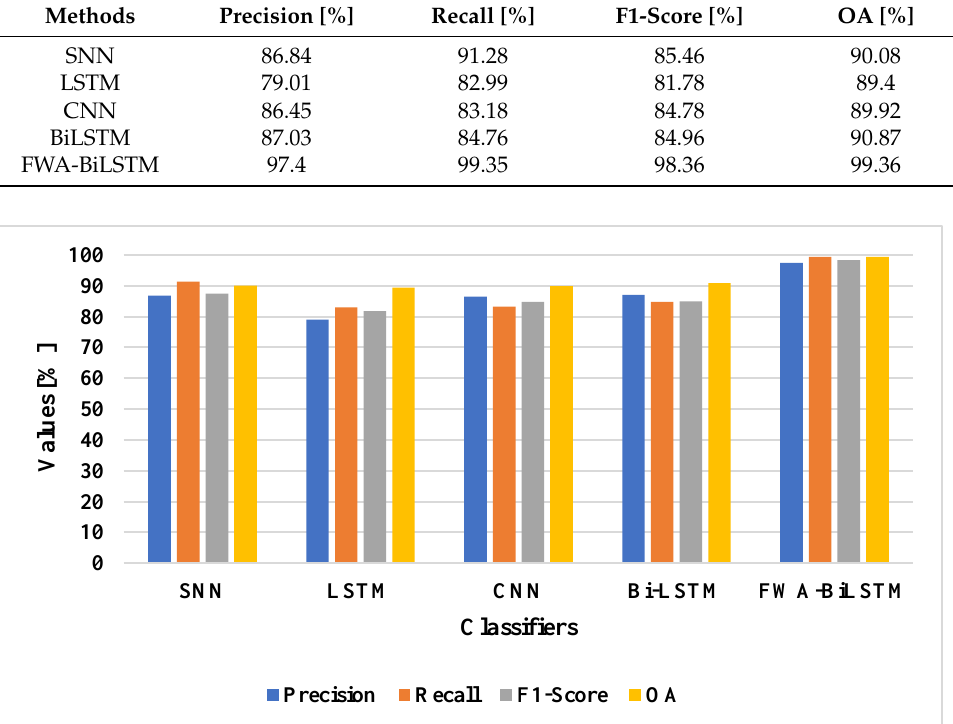
Table 6. Performance of classifier with attention layer on SVD dataset.